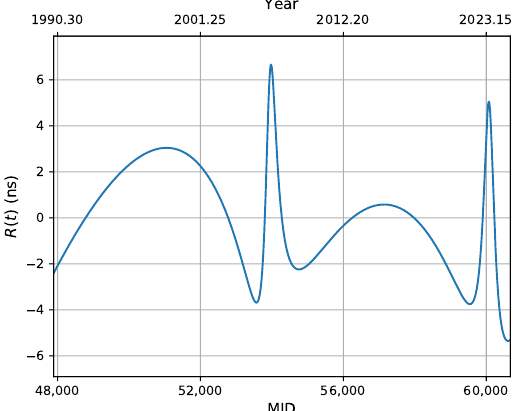
Figure 14. Timing residuals induced by inspiral GWs from OJ 287’s SMBH binary on a typical PTA pulsar PSR J0751 + 1807. We let the pulsar distance to be 1.4 Kpc [120] while SMBH binary parameters as listed in Section 1.1 with its luminosity distance to be 1.6 Gpc. Timing of milli-second pulsars with SKA are expected to achieve similar timing